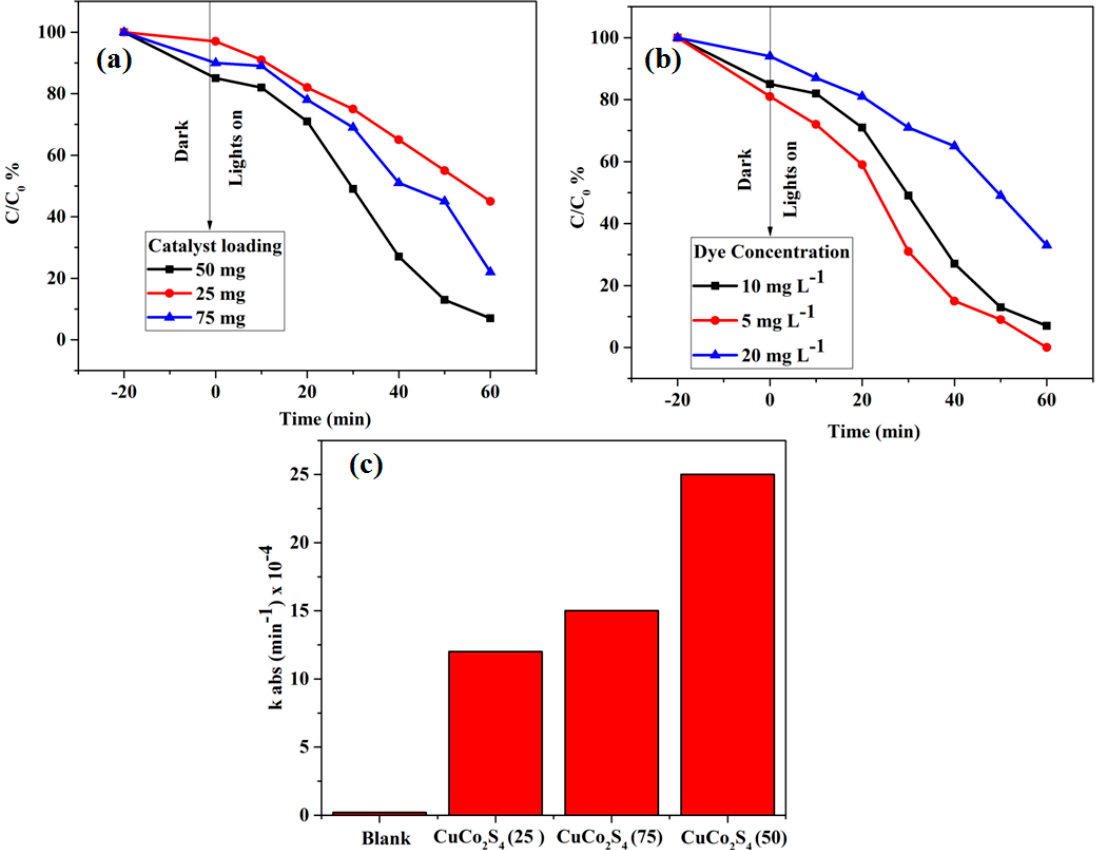
Figure 5. ( a ) Photodegradation of MB dye under different amounts of crystalline CuCo 2 S 4 ( b ) different concentration of MB dye on CuCo 2 S 4 (50 mg). ( c ) Degradation rate constant of MB over the CuCo 2 S 4 yolk-shells loading.